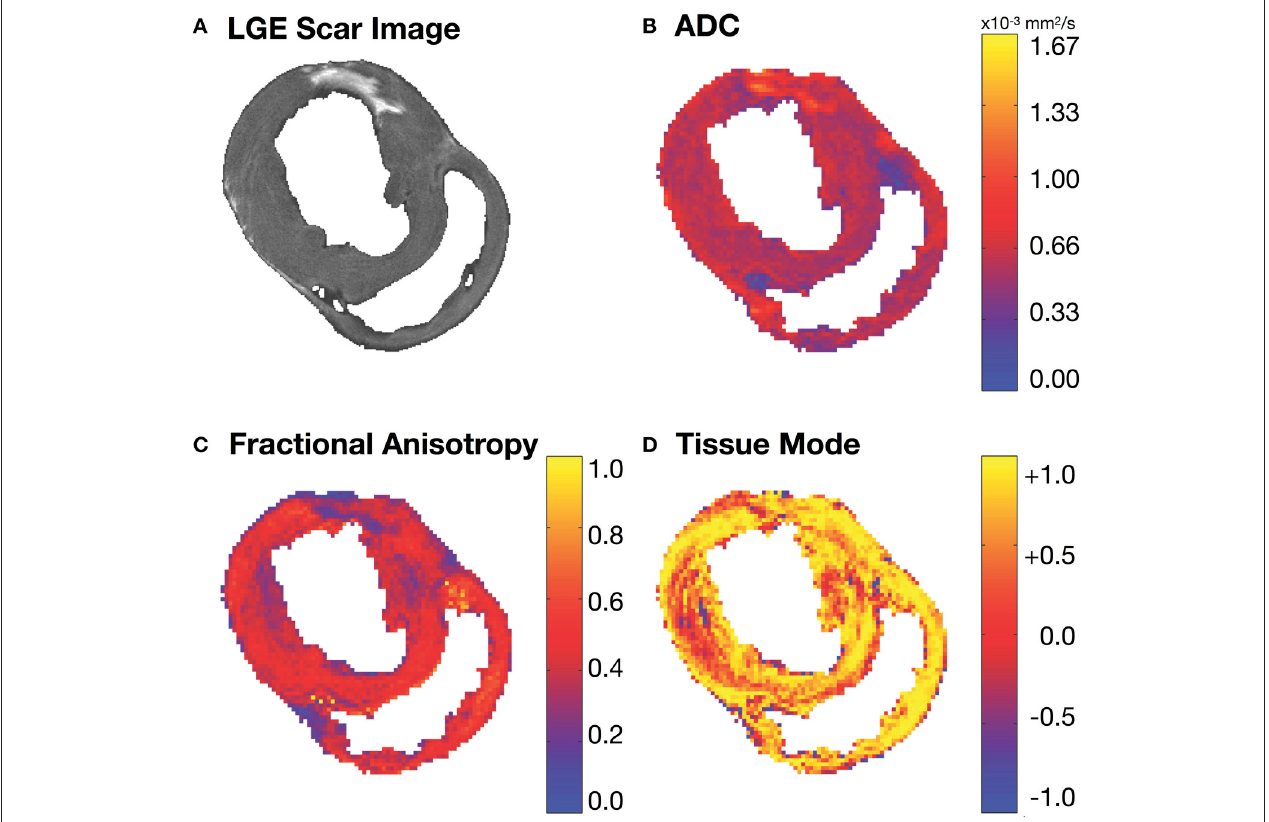
FIGURE 2 | (A) Short-axis LGE slice and the corresponding (B) apparent diffusion coefficient (ADC), (C) fractional anisotropy (FA) and (D) tissue mode maps. Regions of increased ADC (B) and decreased FA (C) match similar regions of hyper-intense SI in the corresponding LGE MRI slice (A) .